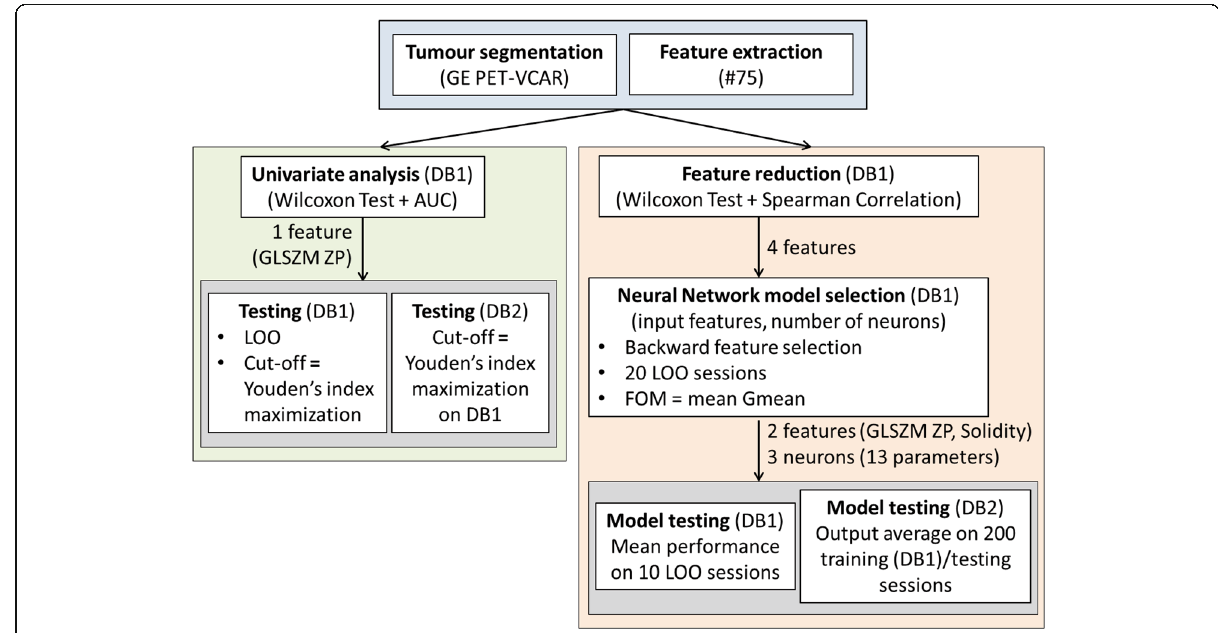
Fig. 1 Complete pipeline of the performed radiomic